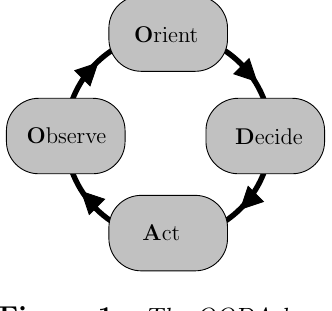
Figure 1: The OODA